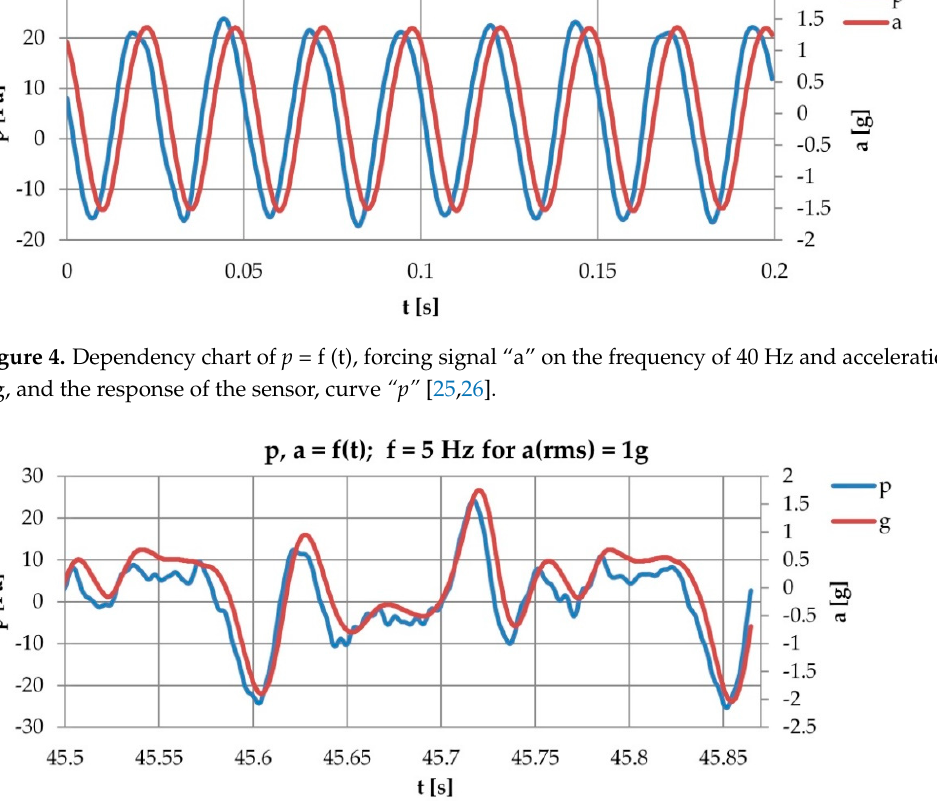
Figure 5. Dependency chart of p = f (t), dependence of instantaneous values for low frequency polyharmonic signal and acceleration a = 1g [25,26].